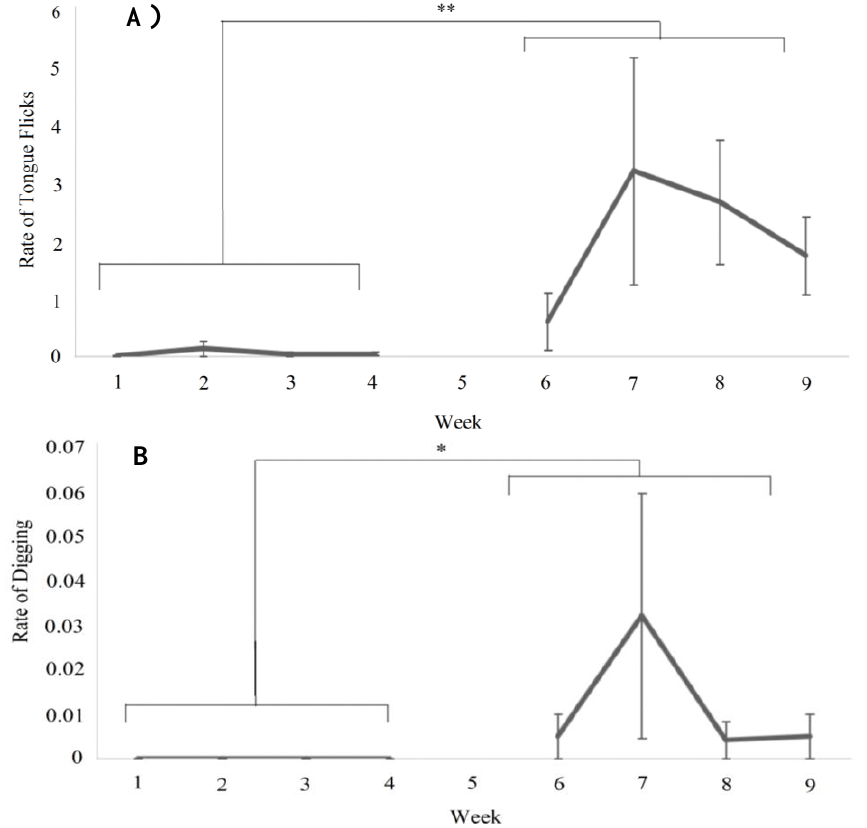
Figure 4 . Average tongue-flicking ( A ) and digging ( B ) per minute (mean ± SE) by week for N = 4 Madagascar giant hognose snakes. The snakes lived in the non-enriched habitats during weeks 1-4 and the enriched habitats in weeks 5-9. No data were collected immediately after their move, in week 5, as indicated by the gap in each graph. ** p < .05 and *.05 ≤ p ≤